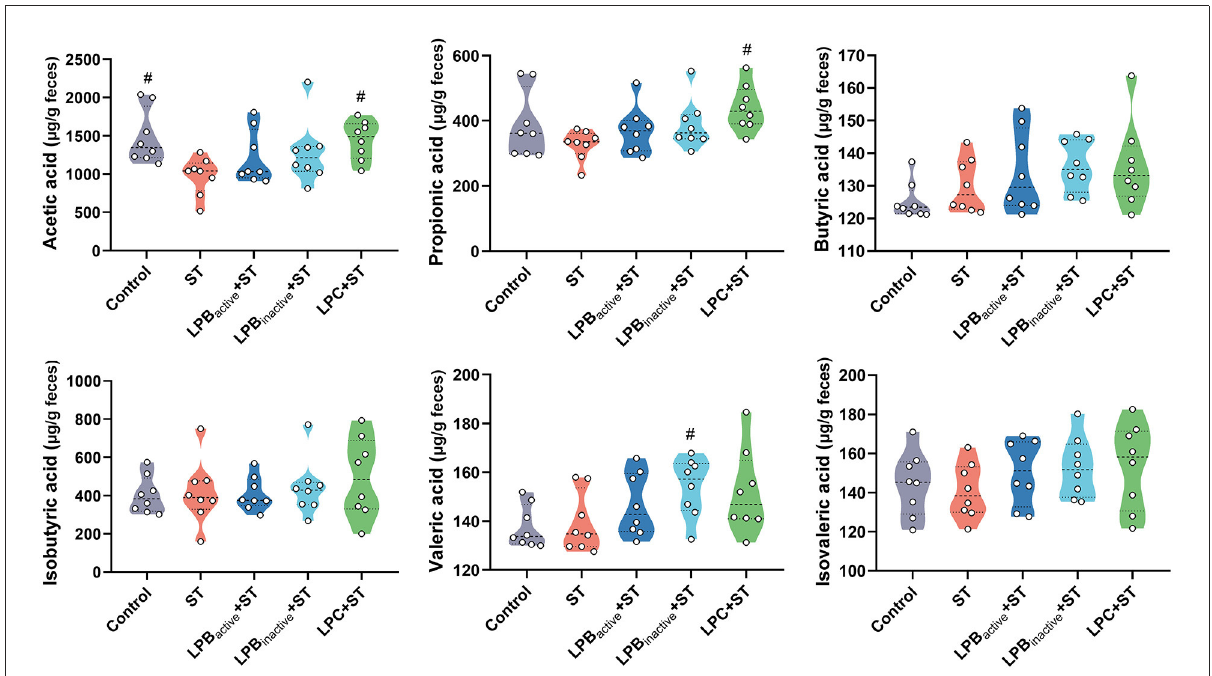
FIGURE9 Violin plots displaying the concentrations of short-chained fatty acids (SCFAs) of cecal microbiota. The data shown as mean ± SEM were analyzed by one-way ANOVA and Tukey’s test ( N = 8 in each group). # Indicates the significance compared to ST group: # p < 0.05.